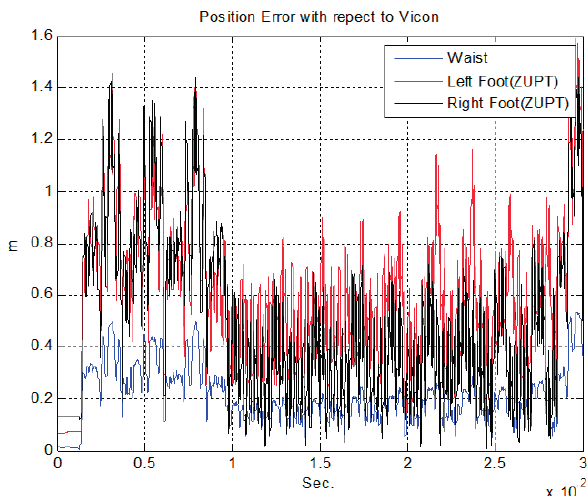
Figure 14. Results of the proposed algorithm and the Vicon system for a 230 m walk.